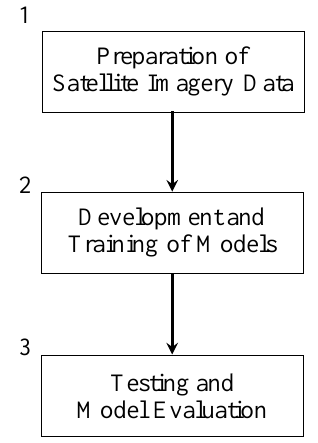
Figure 3. Flowchart for the major steps in the